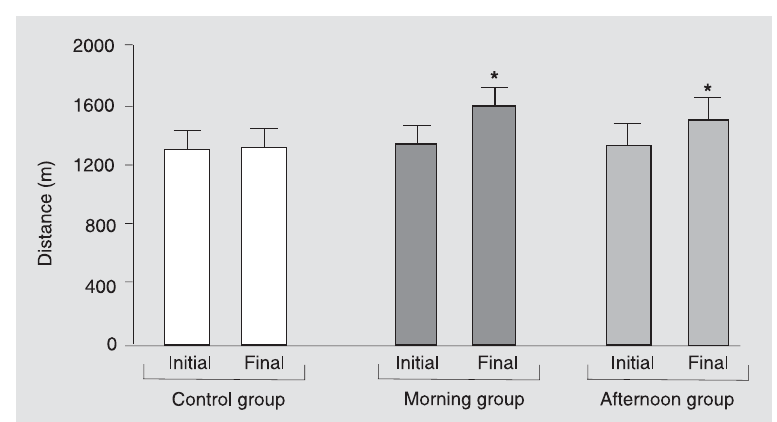
Figure 1. Effect of morning and afternoon exercise on the 9-min run distance covered by asthmatic children. Initial and final indicate the distances run, respectively, before and after a 4-month training program or before and after the same follow-up period for the control group (N = 23). A training program of twice a week 90-min sessions was per- formed at 9:00 h in the morning group (N = 23) and at 14:30 h in the afternoon group (N = 23). *P < 0.05 compared with initial values and to control. P > 0.05 for morning with afternoon final value comparisons (ANOVA).